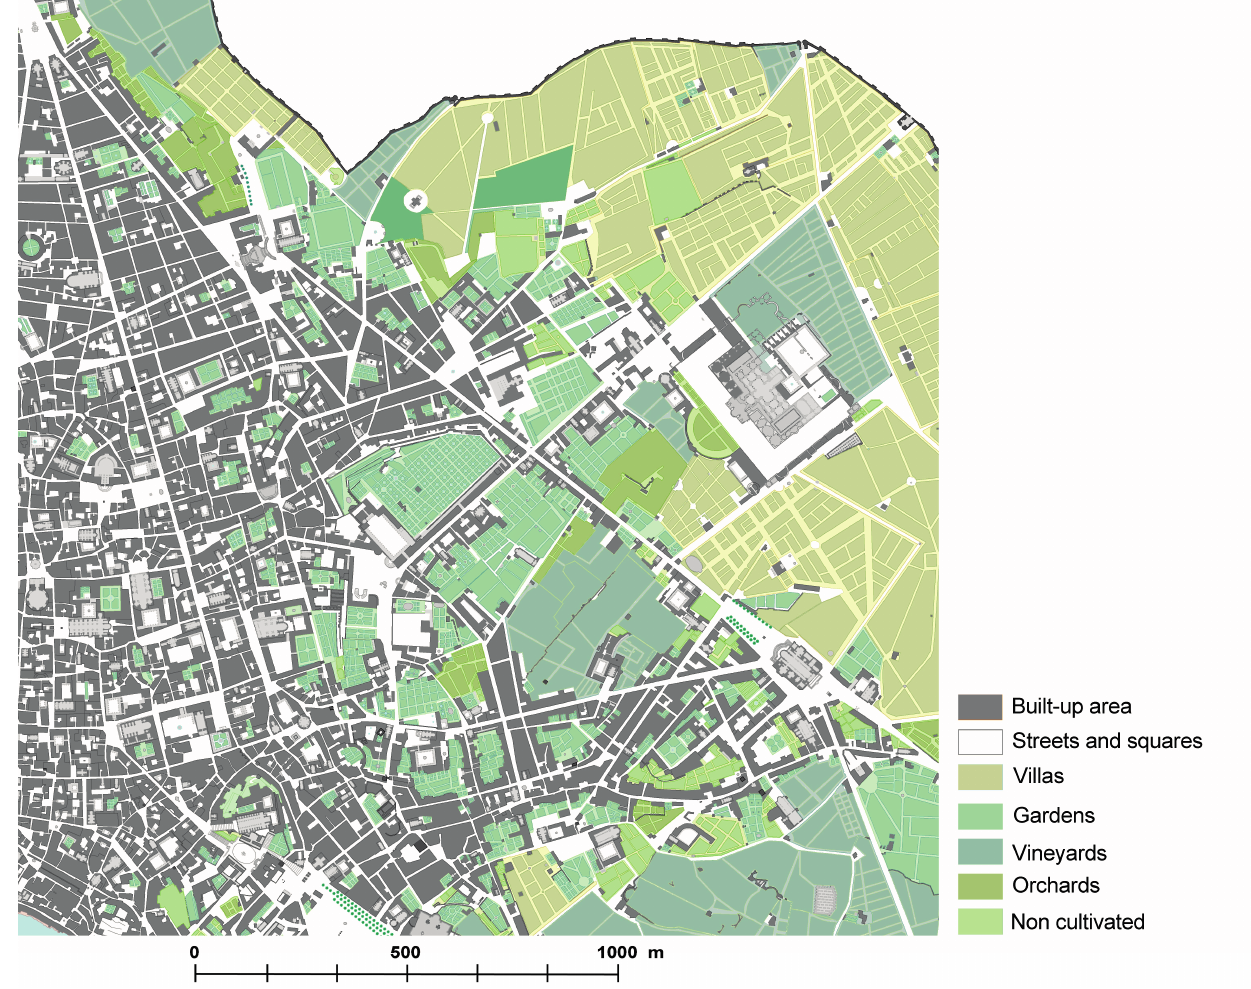
Figure 7. Urban land use map in 1748,